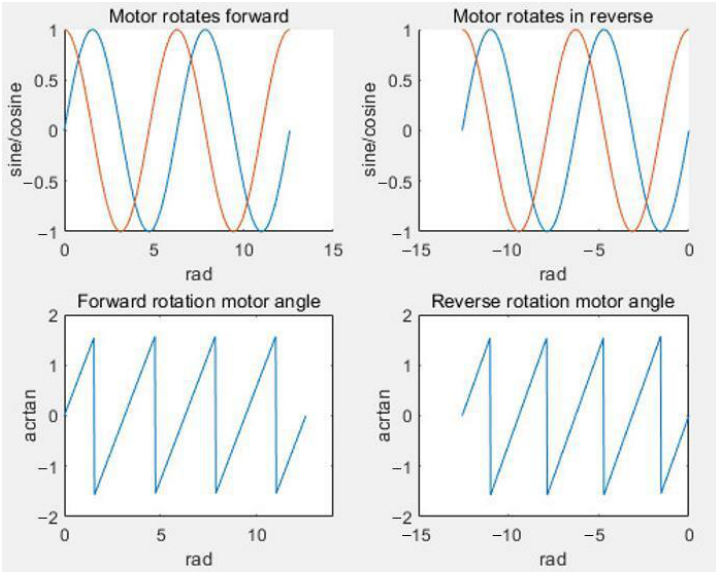
Figure 14. Magnetic encoder angle and motor angle.